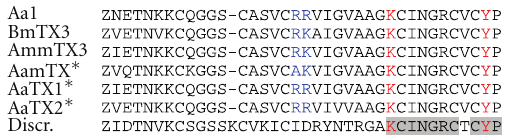
Figure 4: Amino acid sequences of the toxins from the α -KTx 15 subfamily. Aa1 [46], AaTX1, and AaTX2 [48] are from Androctonus australis ; BmTX3 [47] is from Buthus martensii ; AmmTX3 [22] is from Androctonus mauretanicus ; AamTX [49] is from Androctonus amoreuxi . Discrepin [54] is from the Venezuelan scorpion Tityus discrepans . Single letter notation is used for amino acid sequences. Z is pyroglutamic acid. ∗ Indicates putative amino acid sequence deduced from cloned cDNA oligonucleotide sequence. The β -sheet consensus sequence is in